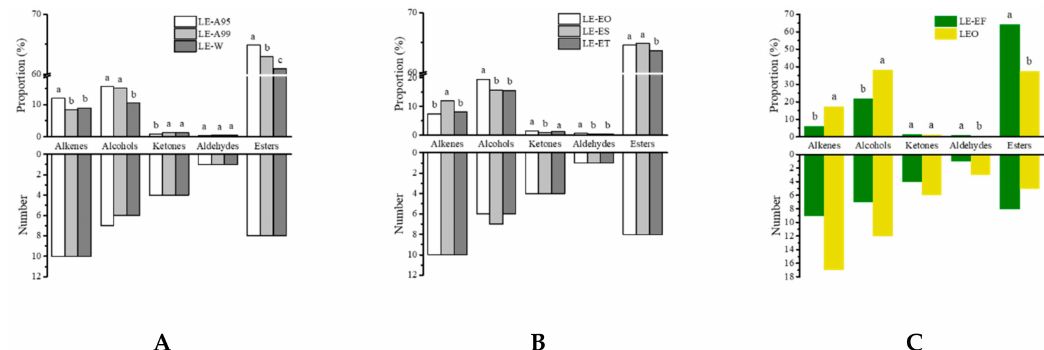
Figure 1. Aroma profiles of lavender extracts and lavender essential oil. ( A ) The proportion and number of volatile categories from lavender extracts with di ff erent extraction solvents. ( B ) The proportion and number of volatile categories from lavender extracts with di ff erent extraction times. ( C ) The proportion and number of volatile categories from lavender essential oil and lavender extracts under the optimized extraction conditions. LE-W—extraction with purified water; LE-A95—extraction with 95% edible ethanol; LE-A99—extraction with 99% edible ethanol; LE-EO—extraction once; LE-ES—extraction twice;